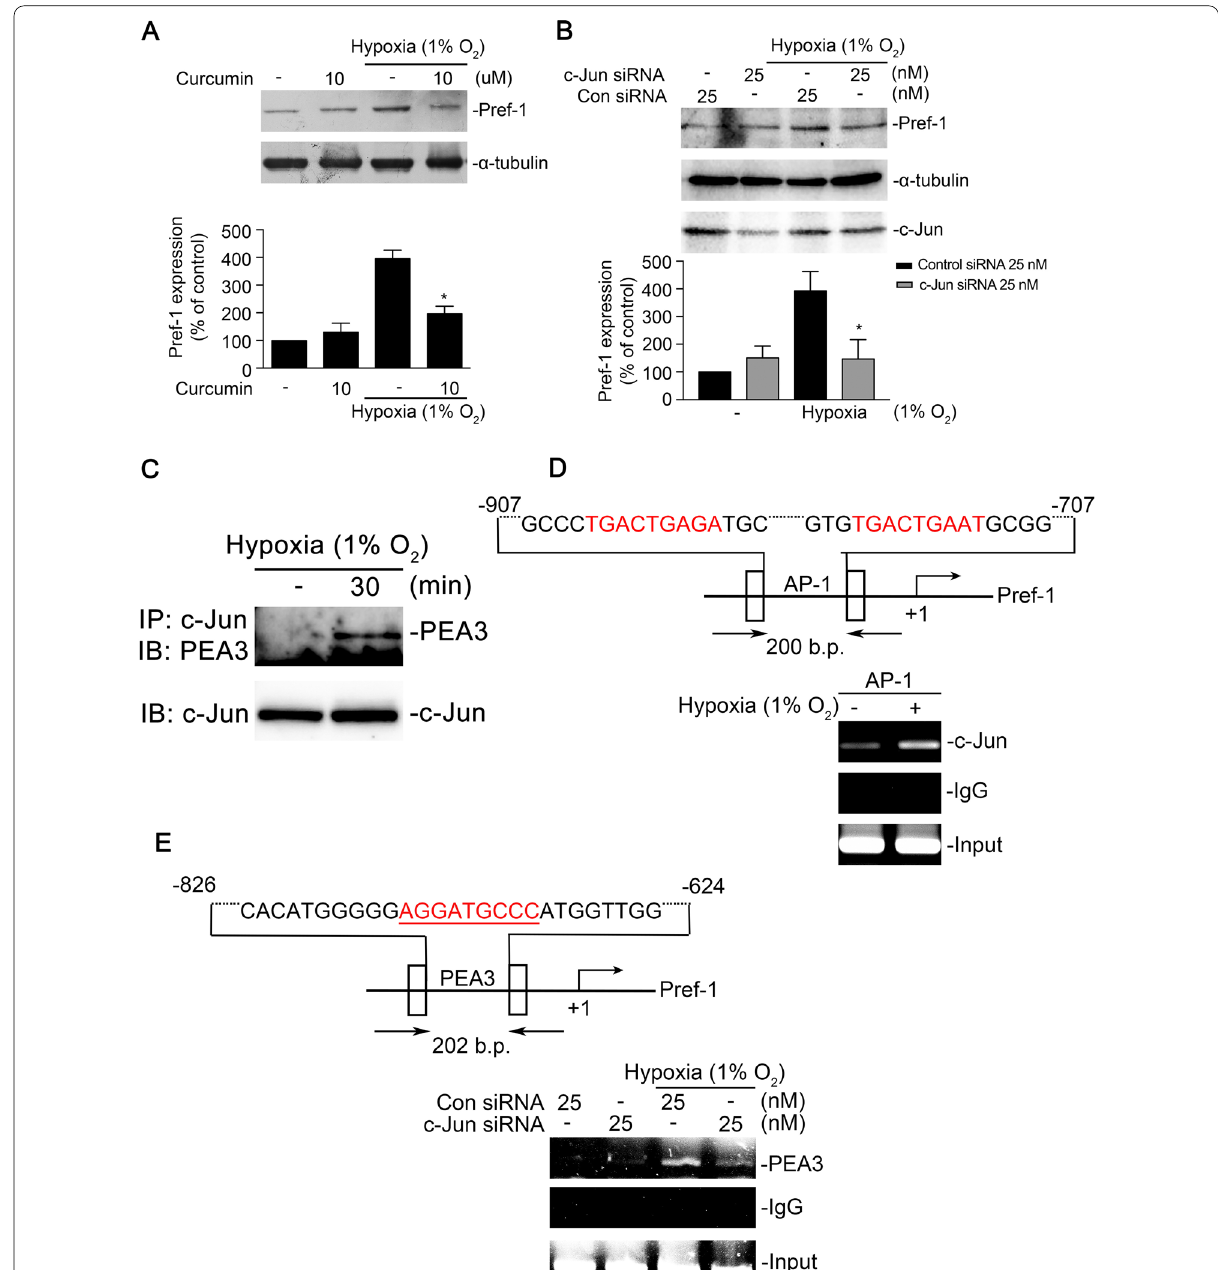
Fig. 5 Involvement of AP‑1 in hypoxia‑induced Pref‑1 expression in WI‑38 cells. A Cells were pretreated with curcumin (10 μM) for 30 min and then stimulated with hypoxia (1% O 2 ) for another 4 h. Pref‑1 and α‑tubulin were detected in cell lysates. Data are presented as the mean S.E.M. ± for three independent experiments. * P < 0.05, compared with the hypoxia group. B WI‑38 cells were transfected with control siRNA or c‑Jun siRNA for 24 h and then subjected to hypoxia (1% O 2 ) for another 4 h. Western blotting was performed to assess the levels of Pref‑1, α‑tubulin, and c‑Jun in cell lysates. Data are presented as the mean S.E.M. of five experiments. * P < 0.05, compared with the control siRNA group. C WI‑38 cells ± were exposed to hypoxia (1% O 2 ) for 30 min. Cells were lysed with IP lysis buffer and then immunoprecipitated with the anti‑c‑Jun antibody. The immunoprecipitated complex was detected through immunoblotting with an anti‑PEA3 antibody. Typical traces were demonstrative of three experiments. D Schematic of the AP‑1 binding site located on the Pref‑1 promoter. WI‑38 cells were exposed to hypoxia (1% O 2 ) for 30 min. The AP‑1 binding site of the Pref‑1 promoter region was detected through ChIP assay. Typical traces were presented in all three experiments. E Schematic of the PEA3 binding site located on the Pref‑1 promoter. After transfection with c‑Jun siRNA for 24 h, cells were subjected by hypoxia for 30 min, The PEA3 binding site of the Pref‑1 promoter region was detected through ChIP assay. Typical traces were presented in all three